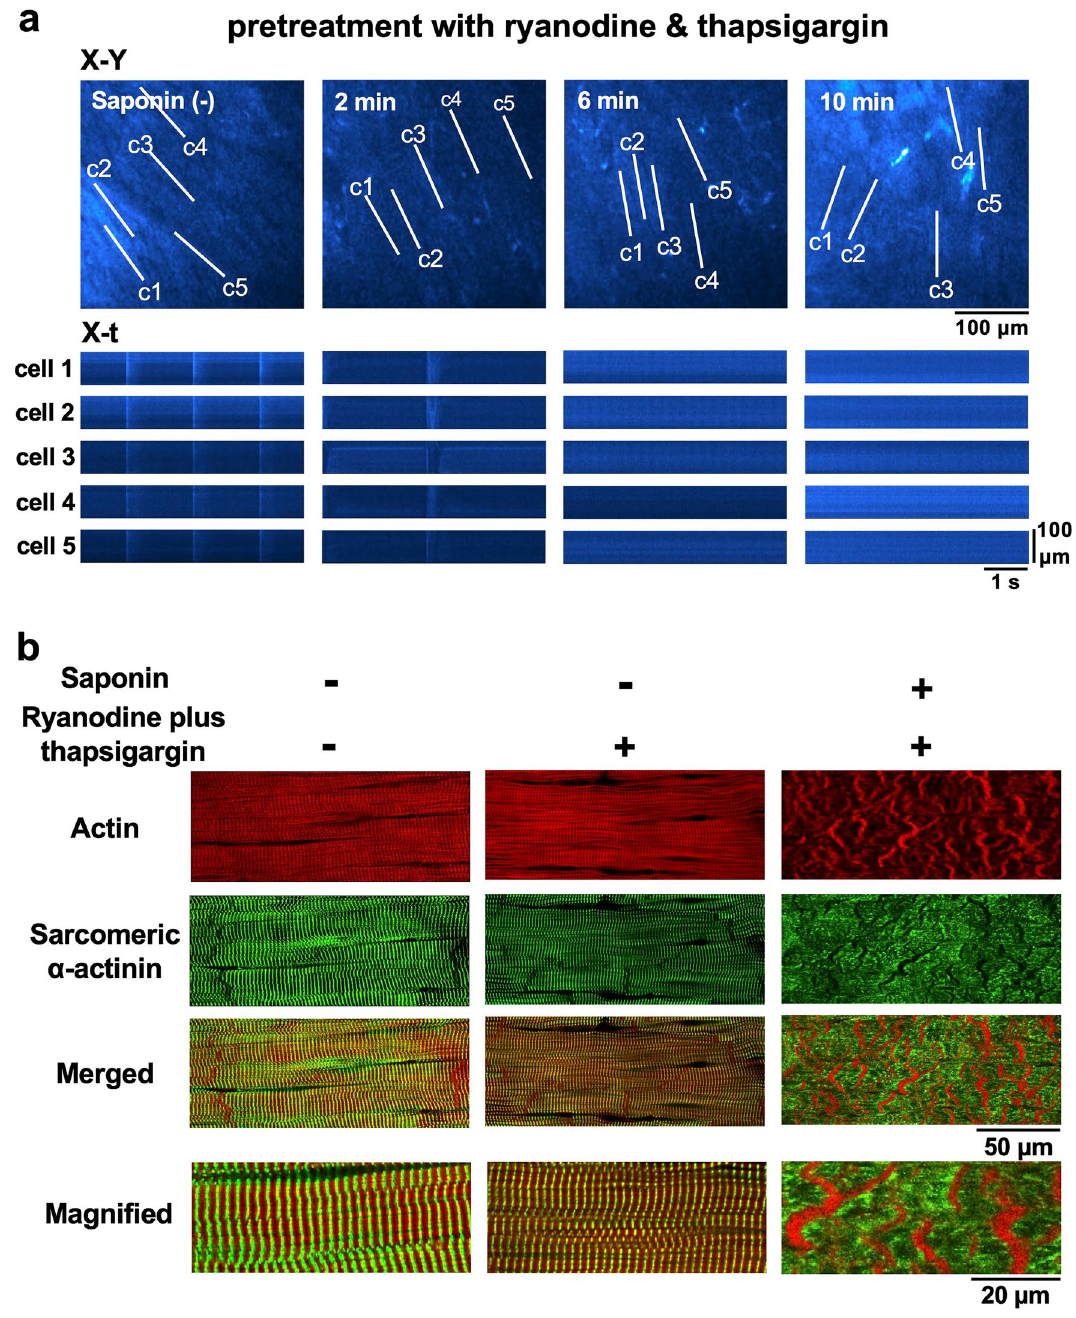
Figure 4. Changes in the saponin-induced contraction bands under depletion of Ca 2+ released from the SR by ryanodine (1 μM) and thapsigargin (5 μM). ( a ) The X–Y and X-t fluo4-fluorescence images before and 2 min, 4 min, and 6 min after commencement of saponin perfusion. Note the absence of Ca 2+ waves before and after saponin application. ( b ) Fluorescence images of the subepicardial myocardium in the absence of saponin with ( middle ) and without ( left ) ryanodine (1 μM) and thapsigargin (5 μM). Fluorescence images of the saponin- induced contraction bands under combined pretreatment with ryanodine and thapsigargin ( right Saponin-induced membrane permeabilisation progressively lengthened the half-decay time (T 1/2 ) of these agonal waves. In this regard, the reduction in wave frequency may result in the lengthening of the Ca 2+ restitu- tion kinetics in the SR 34 , but this would not adequately account for the extensive prolongation of T 1/2 observed in this study. Instead, we assume that the dissipation of cellular ATP may be responsible for these increased T 1/2 values, as they markedly increased after 6 min of saponin exposure (Supplementary Fig. 4b), at which time the fluorescence intensity of TMRM was significantly reduced indicating opening of the mPTP. The decreases in the ATP content of these cells may well lead to inhibition of SERCA, which would slow the decay and reduce